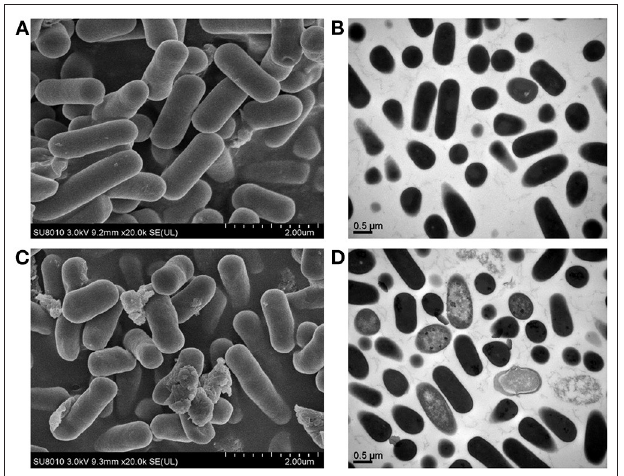
FIGURE 1 | Images from scanning electron microscope (SEM) and transmission electron microscope (TEM). (A) SEM image of the normal group; (B) TEM image of blank bacterial cells; (C) SEM picture of lactic acid bacteria after lead adsorption; (D) TEM image of lead-adsorbed lactic acid bacteria